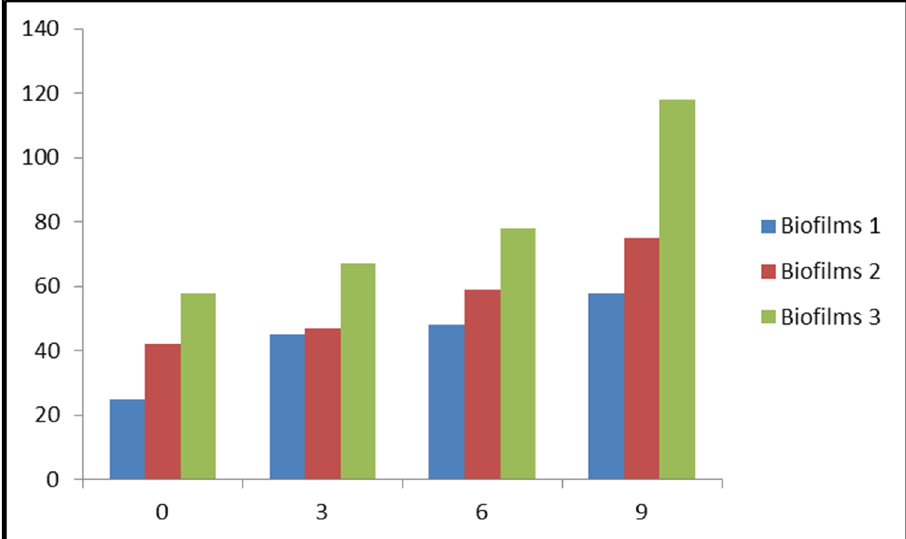
Figure 5. Anti-Microbial test result on PLA the variated of B1 (Biofilm 1), B2 (Biofilm 2) and B3 (Biofilm 3)